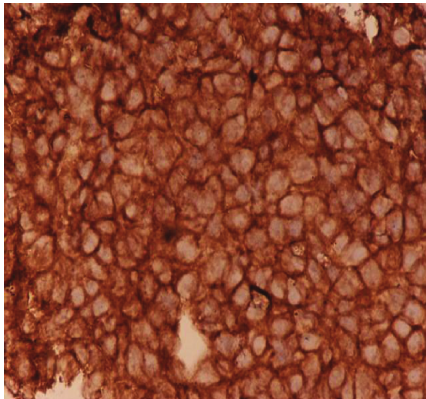
Figure 2: Histopathological examination of the excised tissues shows malignant small round cells with some rosette formation, suggesting a diagnosis of small round cell